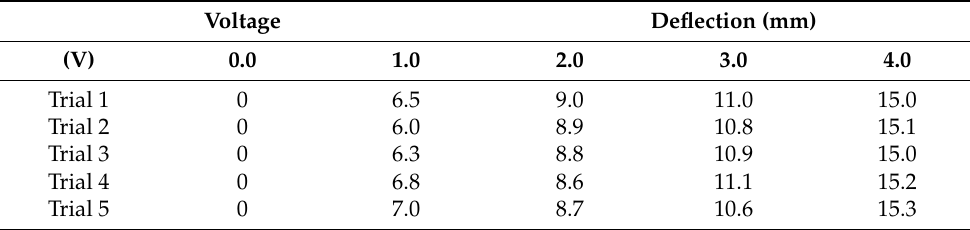
Table 1. Deflection data (experimentally obtained) of the SPVC–PTA–Pt polymer soft actuator.